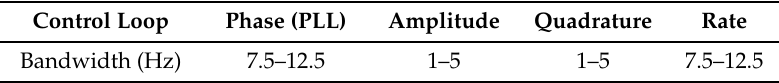
Table 8. The bandwidth goals of control loop.